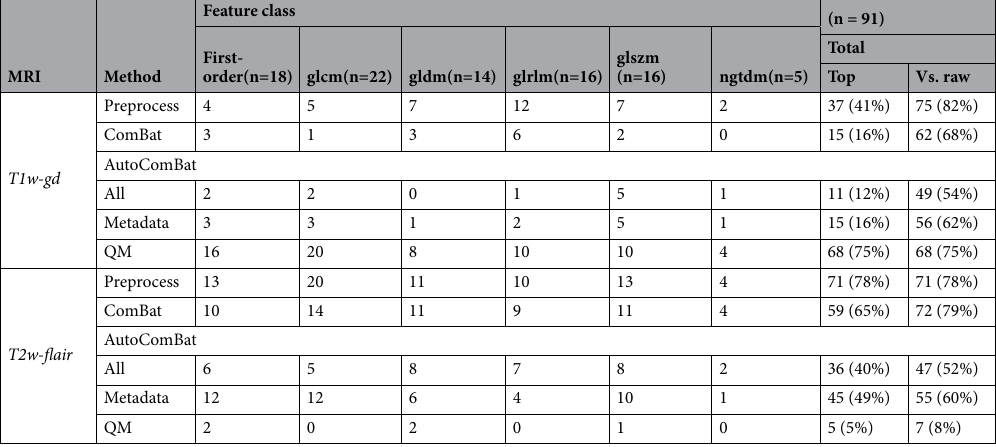
Table 3. Counts (%) of features for each harmonization method with a RSD (95% CI) lower than the one corresponding to the raw images for the T1w-gd and T2w-flair MRI on the test set. The main part of the table gives the number of features for which the considered method is evaluated as the best one, which is called “Top”. Total vs. Raw gives the total number of features for each method that are significantly better compared to Raw. For AutoComBat, “All” means the use of Metadata and Quality Metrics. QM Quality